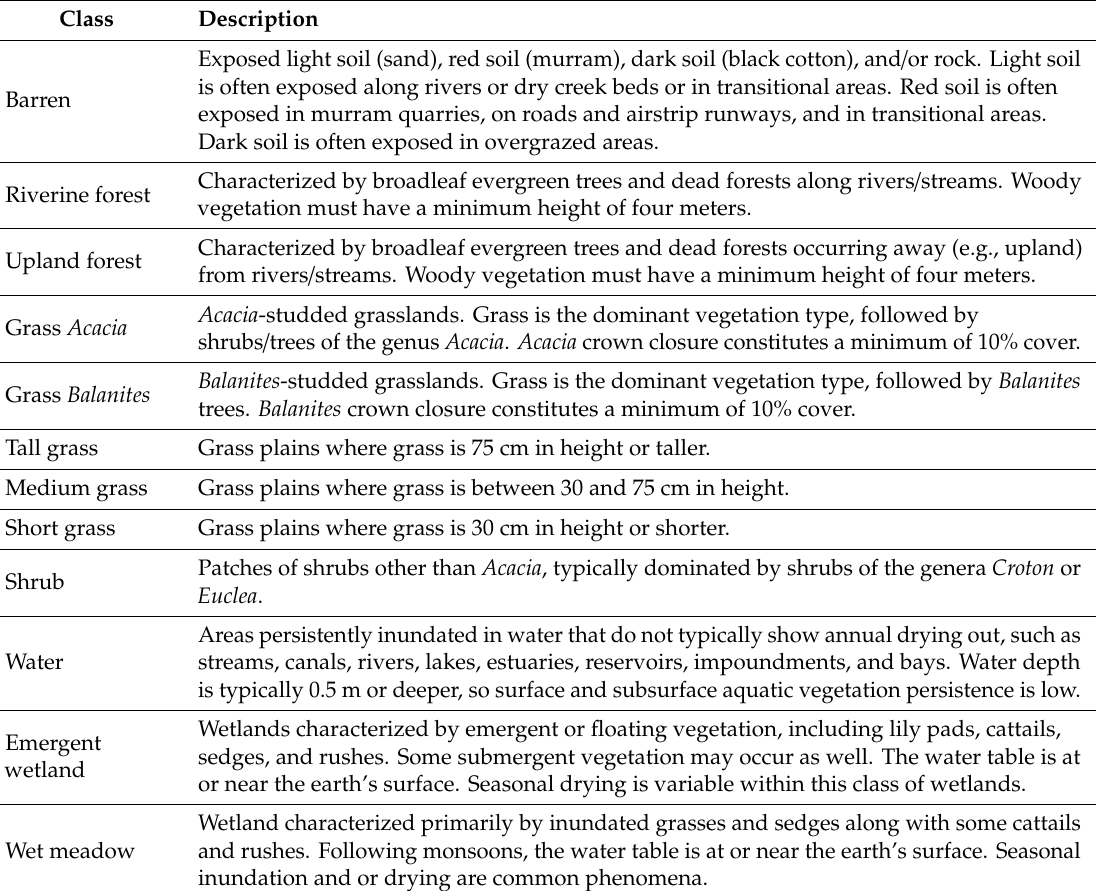
Table 1. Description of each land cover class